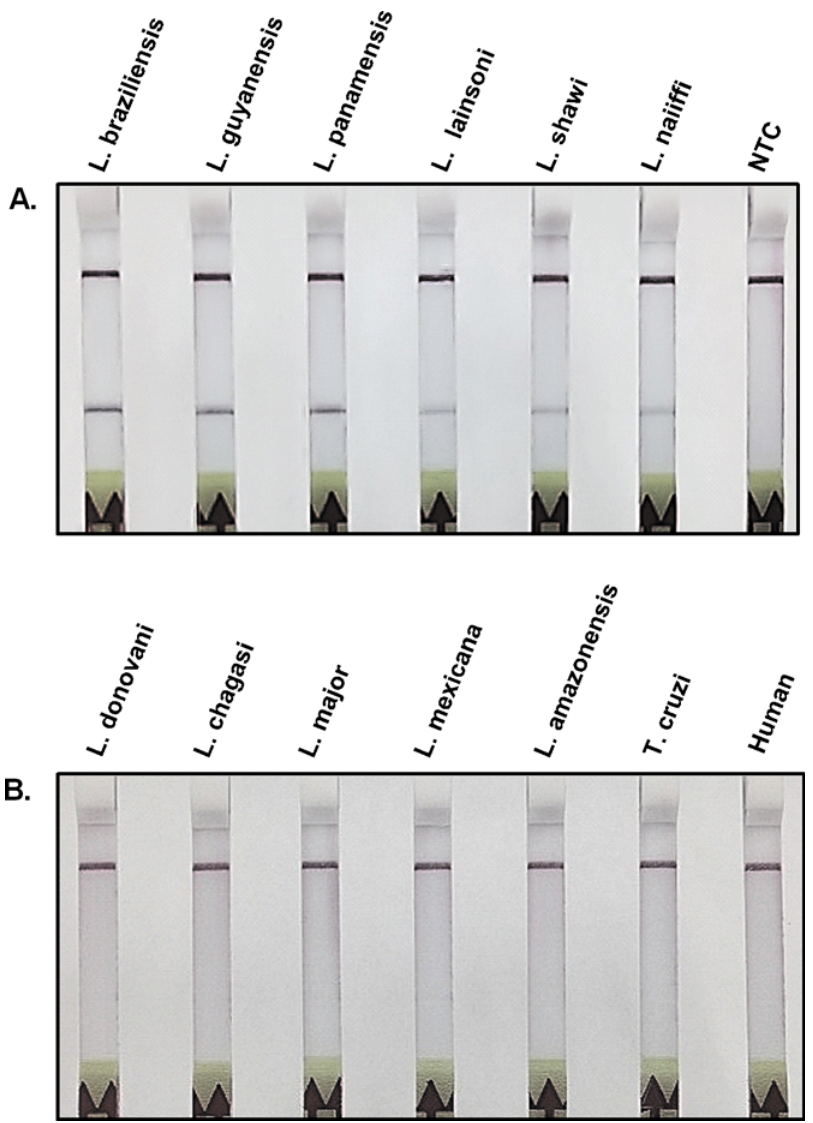
Fig 2. Specificity of RPA-LF to amplify species of the Viannia subgenus. A) The most relevant L . Viannia species ( L . braziliensis , L . guyanensis , L . panamensis ) produced stronger bands in the lateral flow strip than other less common species of this subgenus. B) Species of the Leishmania subgenus, Trypanosoma cruzi , and human DNA were not amplified by the RPA-LF test. NTC = no template control.